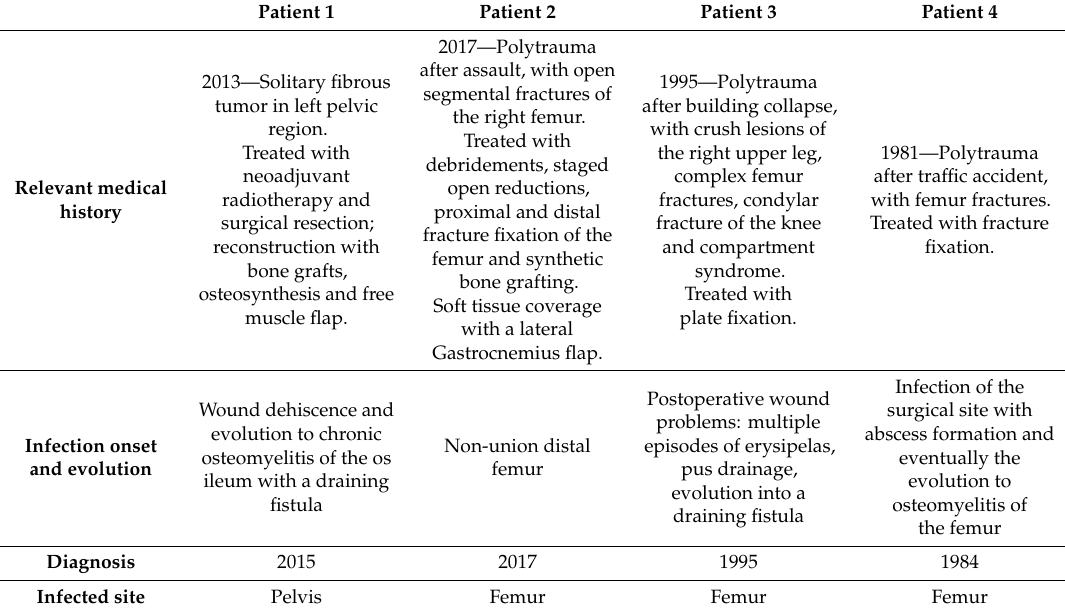
Table 1. Patient